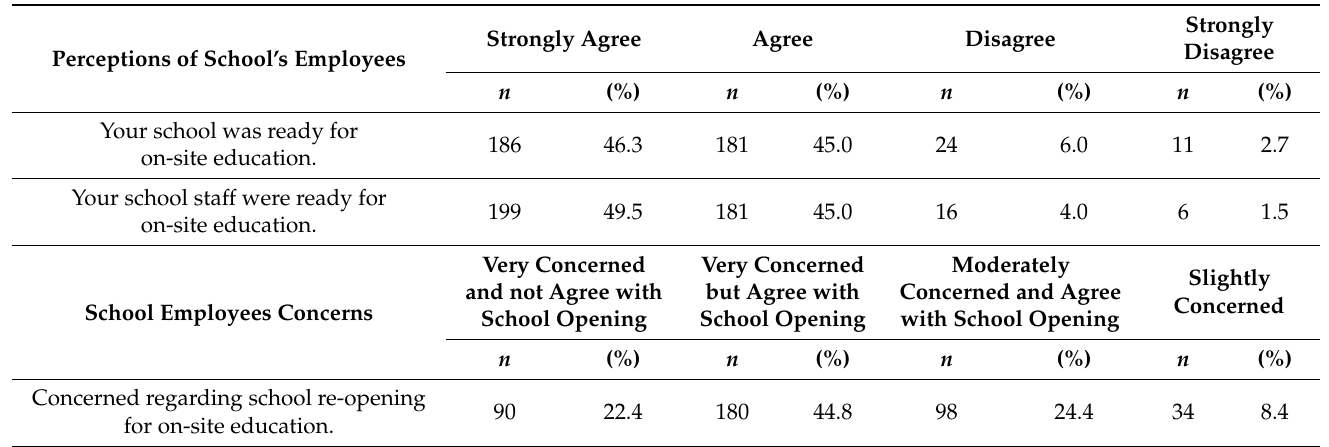
Table 3. Perceptions and concerns of school employees regarding on-site education during the COVID-19 pandemic.